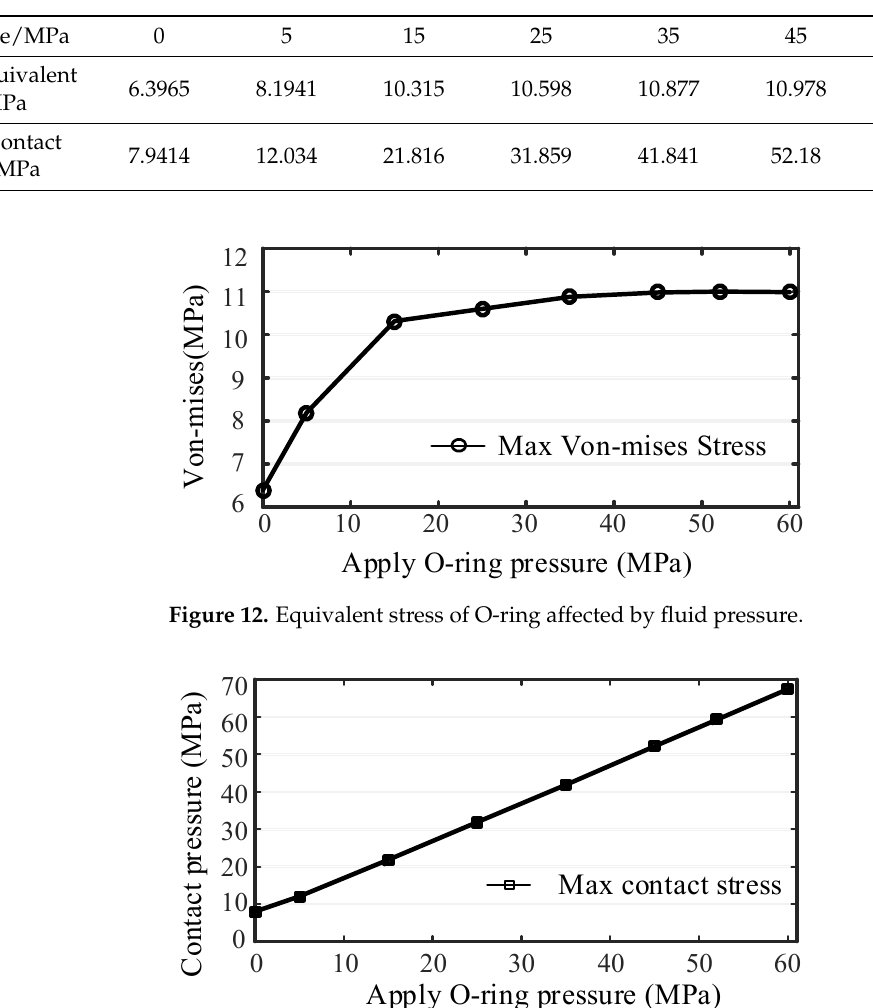
Table 3. Maximum equivalent stress and maximum contact pressure under different medium pressure.